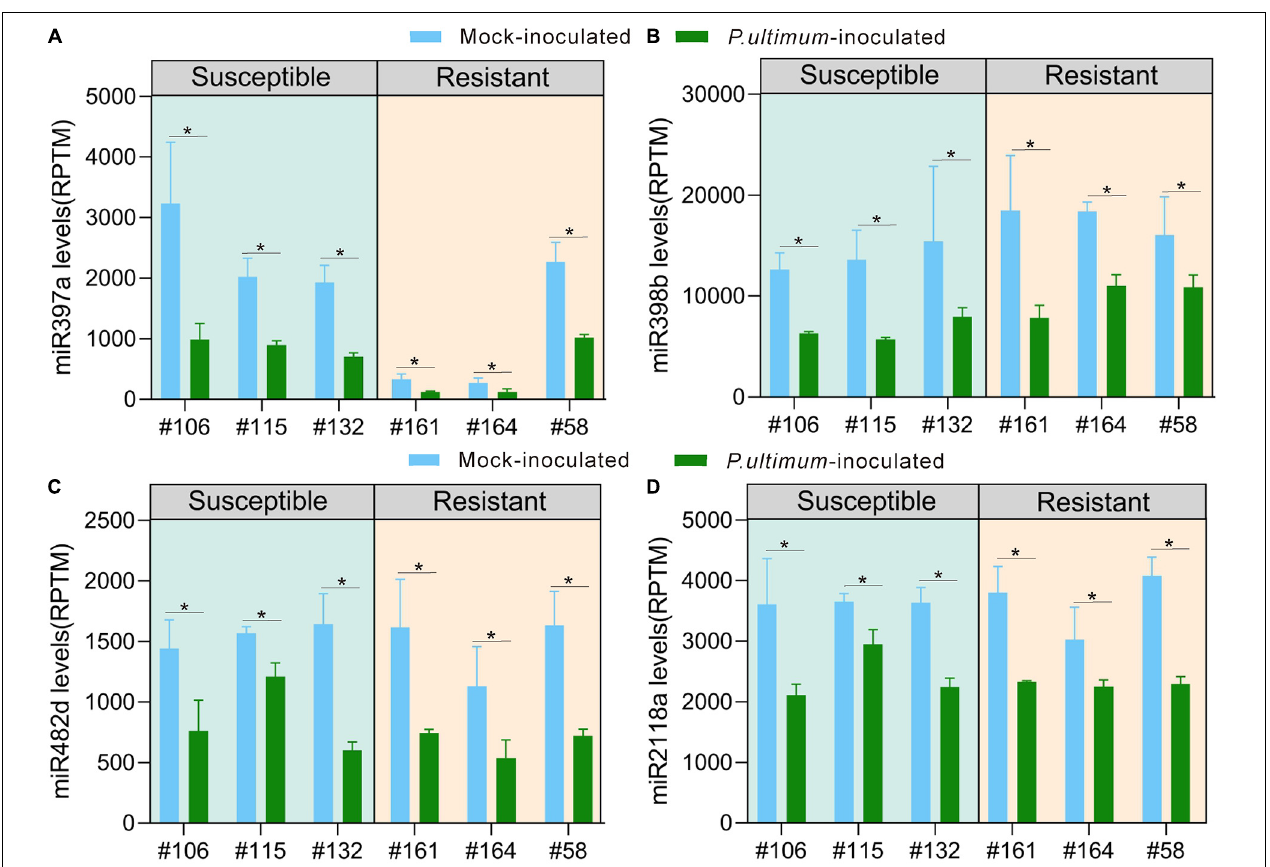
FIGURE 3 | Genotype-specific expression patterns for representing members in selected miRNA families potentially participating in apple roots resistance responses. (A) miR397a; (B) miR398b; (C) miR482d; (D) miR2118a. The numbers on Y axis represent the average values of the normalized read counts from three biological replicates. Genotype/treatment are aligned along X axis; with CK representing mock-inoculation control and “Pu” representing root samples inoculated using P. ultimum . Error bars are the standard deviation (SD) of count values within three biological replicates. Error bars represent SE of three independent biological replicates. Asterisks denote statistically significant differences in a one-tailed Mann–Whitney U test (* P < 0.05).